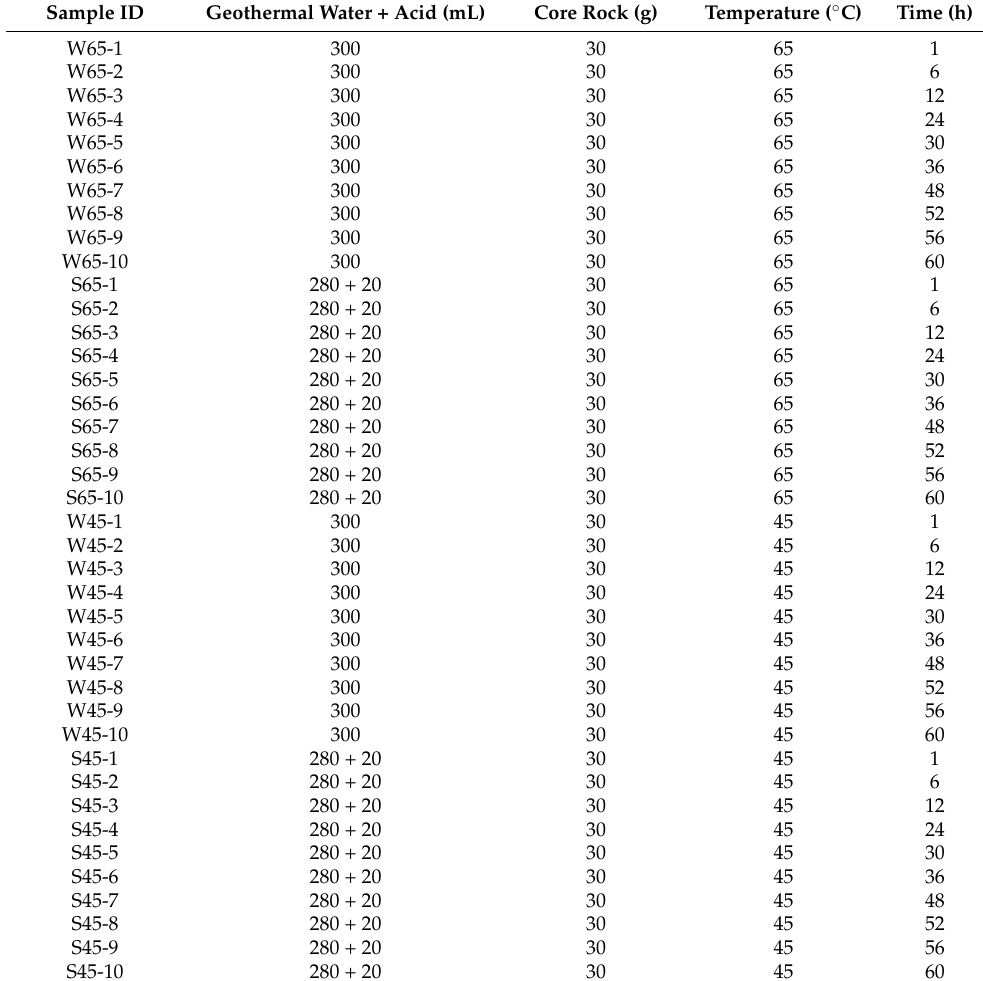
Table 1. Water–rock interaction experimental